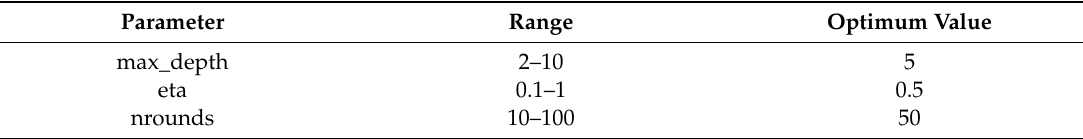
Table 3. Extreme Gradient Boosting regression, which modeled hyperparameters from the grid